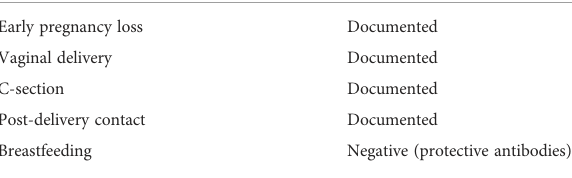
TABLE 2 Events related to virus vertical transmission from mother to